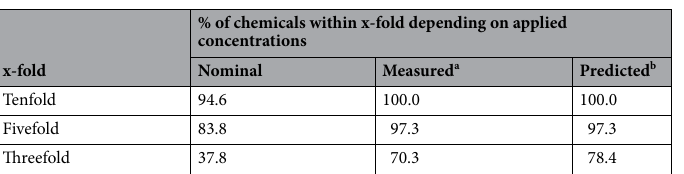
Table 2. Percentage of chemicals of which EC50 values were within the x-fold difference from the measured respective fish LC50s depending on the type of the medium concentrations considered. Fish LC50 and EC50 measured and nominal values were taken from Natsch et al. 29 . a EC50s were determined based on the geometric mean of the concentrations measured at the beginning and the end of the experiment. b EC50s were determined based on the geometric mean of the nominal concentration and the concentration predicted at the end of the experiment.